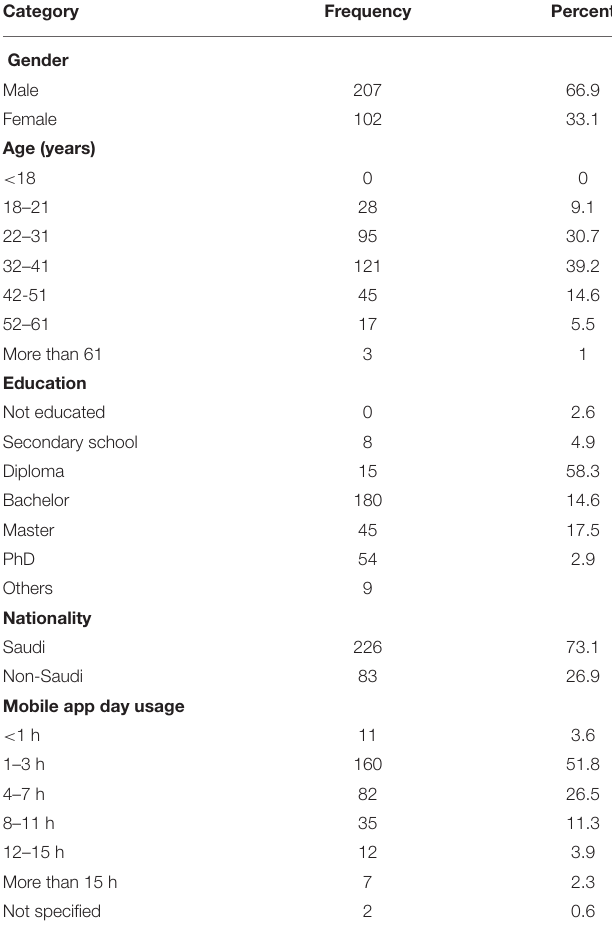
TABLE 3 | Demographic characteristics of